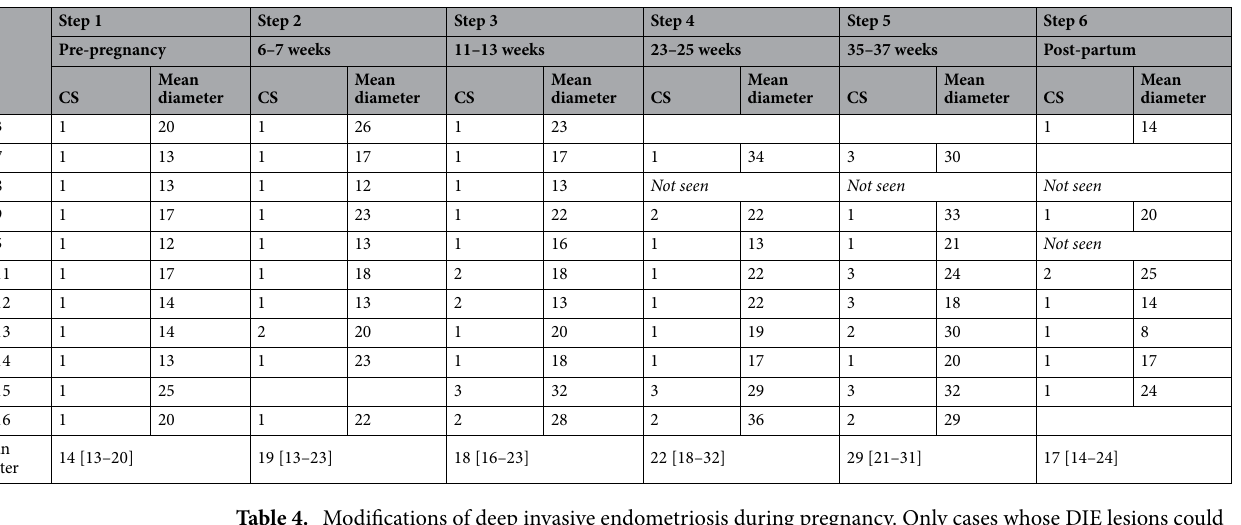
Table 4. Modifications of deep invasive endometriosis during pregnancy. Only cases whose DIE lesions could be identified at least in the 12 weeks’ assessment are included in the table. Cases are not reported in numerical order because we first presented women who also had a decidualized endometrioma and we wanted to respect the numbering given in Supplemental Table 1. From case 7 to case 13, women did not have decidualized endometriomas. From case 14 onwards, women did not carry endometriomas at all. CS color score. Mean diameter of the lesions is reported in mm. Median diameter is presented with the interquartile